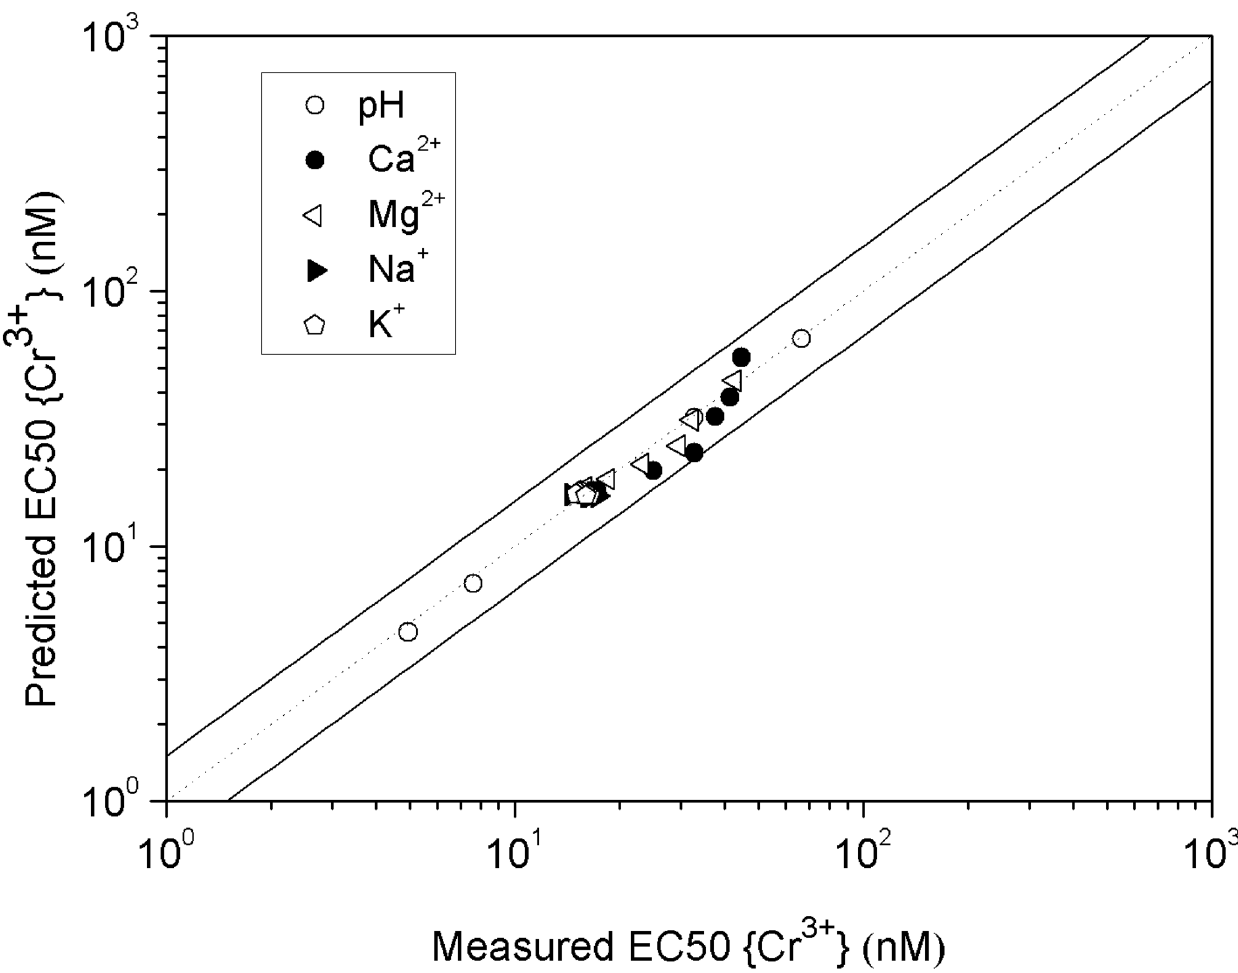
Figure 4. Relationship between the measured and predicted EC50{Cr 3 + } based on the BLM developed in the present study. The solid line indicates a perfect match between measured and predicted EC50{Cr 3 + } values, and the dashed lines indicate the range of a factor of 1.5 between observed and predicted EC50{Cr 3 + } values.